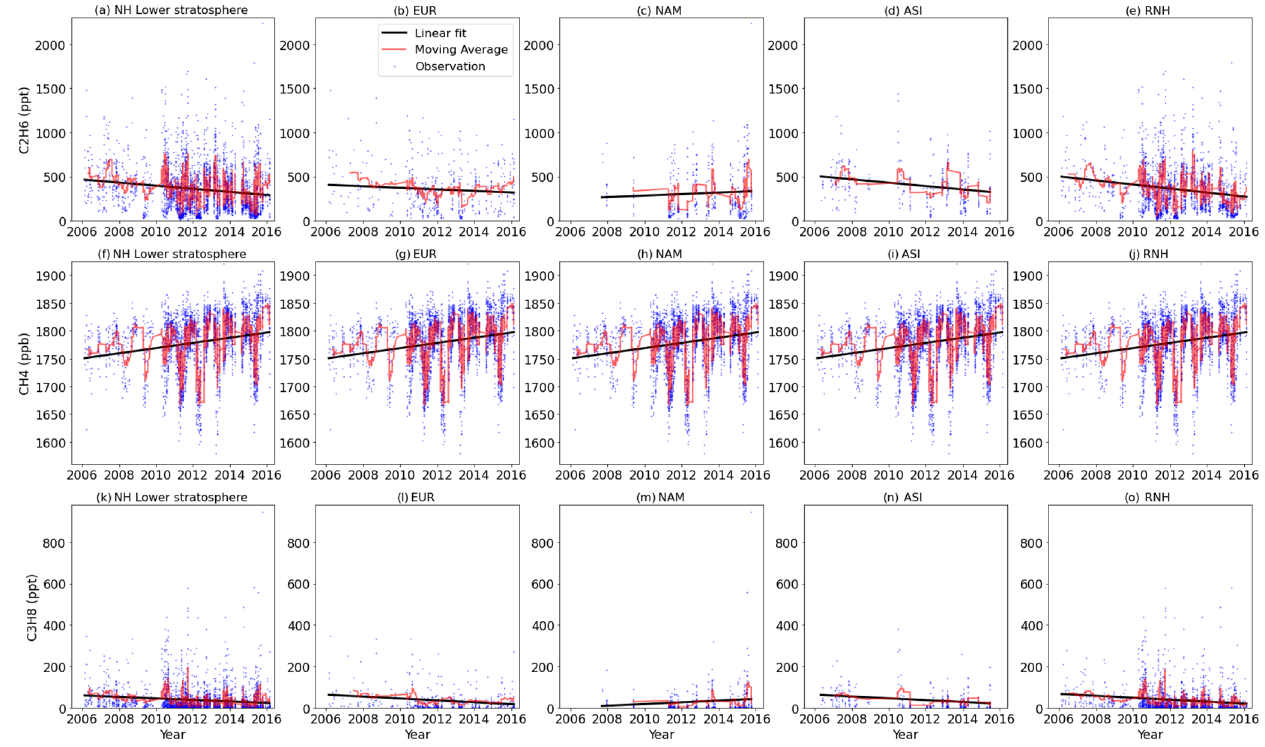
Figure 5. Lower stratospheric ethane, methane and propane mole fractions from observations and linear trends over five regions (whole NH lower stratosphere, EUR, NAM, ASI, and